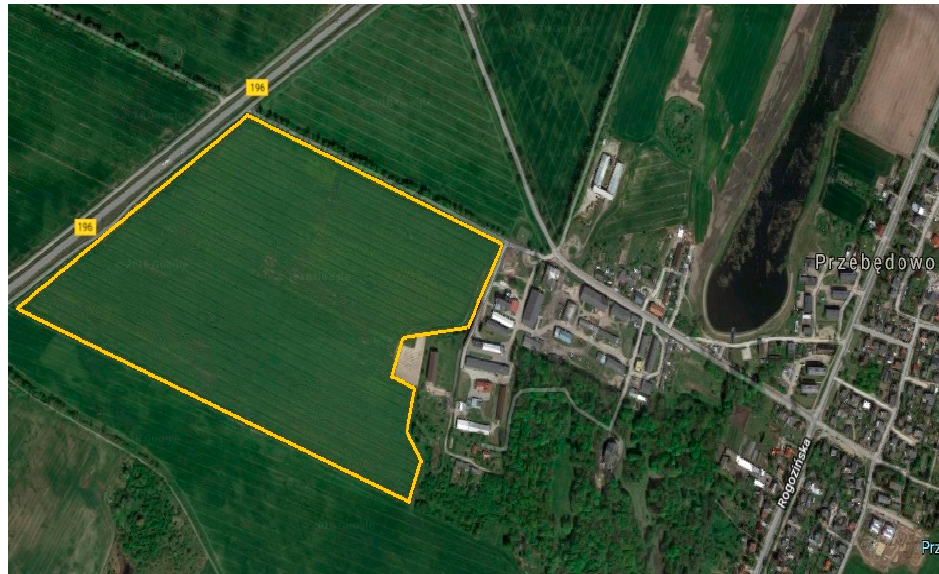
Figure 1. Location of the study field. (source: https://www.google.pl/maps). Table 2. Main characteristics of meteorological conditions during the study on the background of the long-term averages 1 .